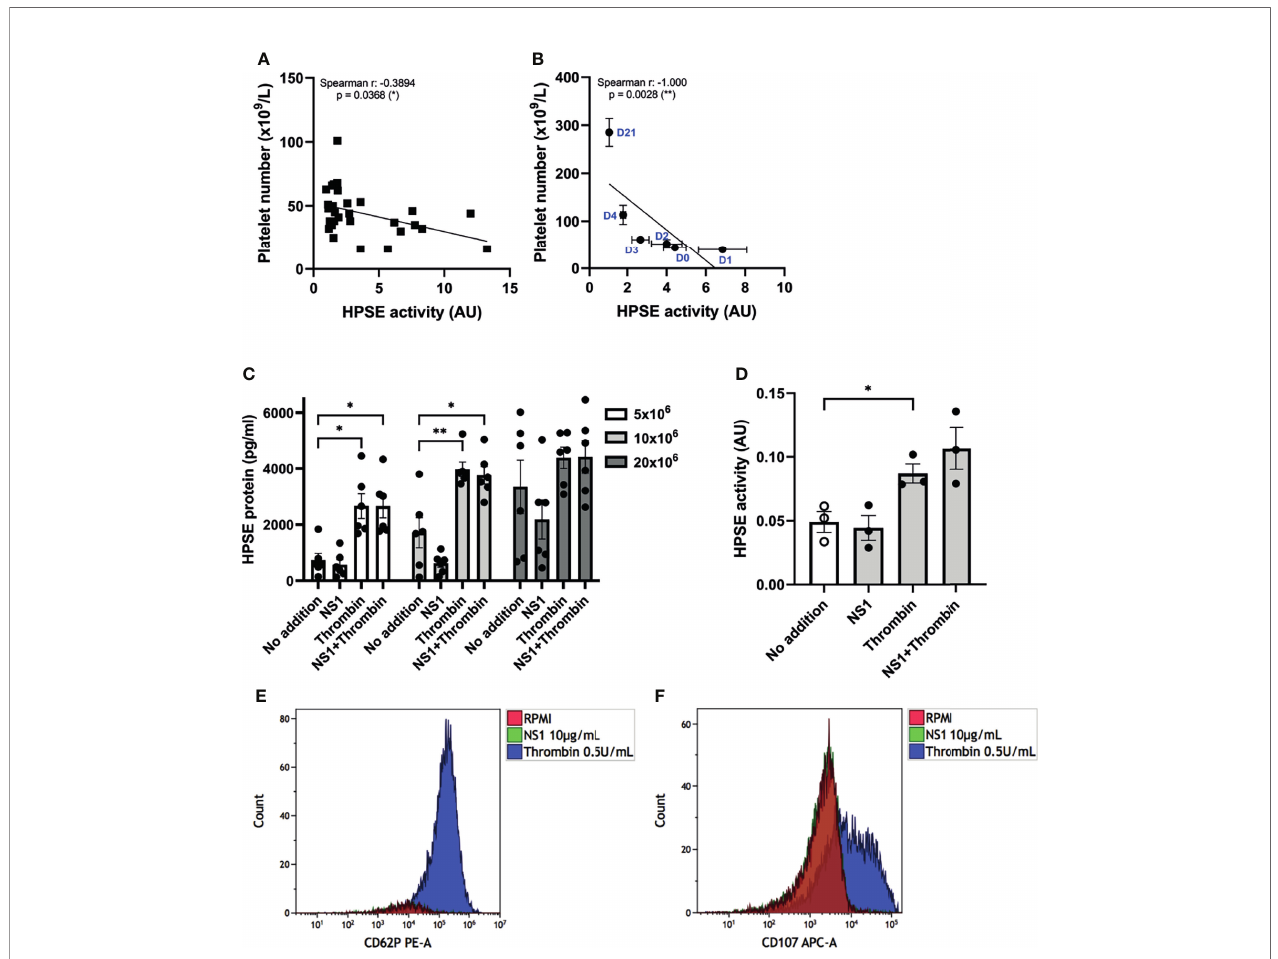
FIGURE 4 | Platelets activation and HPSE activity in dengue patients. (A) Correlation between HPSE activity andplatelet number of acute dengue patients at day 1 upon hospitalization (n=30). (B) Correlation between HPSE activity andplatelet number of acute dengue patients over time(n=10). Foreach timepoint the mean and SEM HPSE activity/platelet number of allpatients measuredat that time point isdepicted. (C) Released HPSE protein from platelet-rich plasma (PRP)ofhealthyvolunteers(N= 6) pretreatedwith 10 µg/mL DENV NS1 or RPMI for 20 minutes, andsubsequently incubatedwith 0.5 U/mLthrombin or RPMI for another 20 minutes. (D) HPSEactivity inthe PRP supernatant (n=3). (E) Expression of p-selectin (CD62P) or (F) lysosomal LAMP-1 (CD107) inplatelets after 20 minutes incubation with DENV NS1 or thrombin as measured by fl ow cytometry. NS1 stimulated platelet fl ow cytometryplots exactly overlay noRPMI platelets plots. The fl ow cytometry data shown isfrom one donor but has been repeatedwith at least three donors. Data werepresentedas mean ± SEM andtestedfor normal distribution with D ’ Agostino & Pearson omnibusnormality test. Statistical differences were calculated using one-way ANOVA followedby Turkey ’ s multiplecomparisons test. Correlation analysiswas performed with Spearman ’ s correlation coëf fi cient (*p < 0.05, **p < 0.01). HPSE, heparanase; NS1, DENV NS1; AU,arbitrary